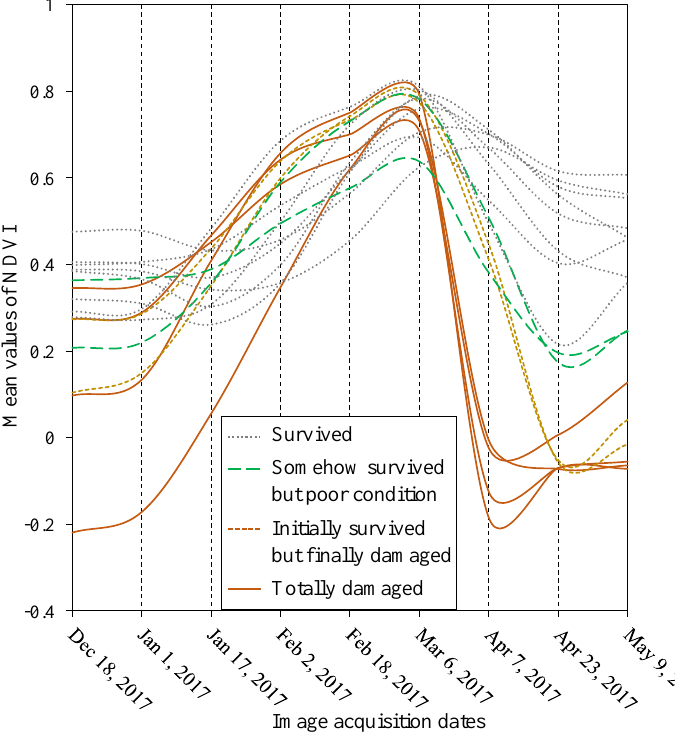
Figure 6. Temporal dynamics of MODIS-derived mean NDVI-values over the planting to harvesting season indicating various boro conditions after the flash flooding event.